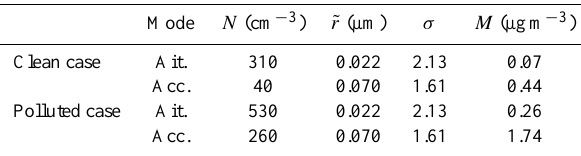
Table 3. Parameters of the lognormal aerosol size